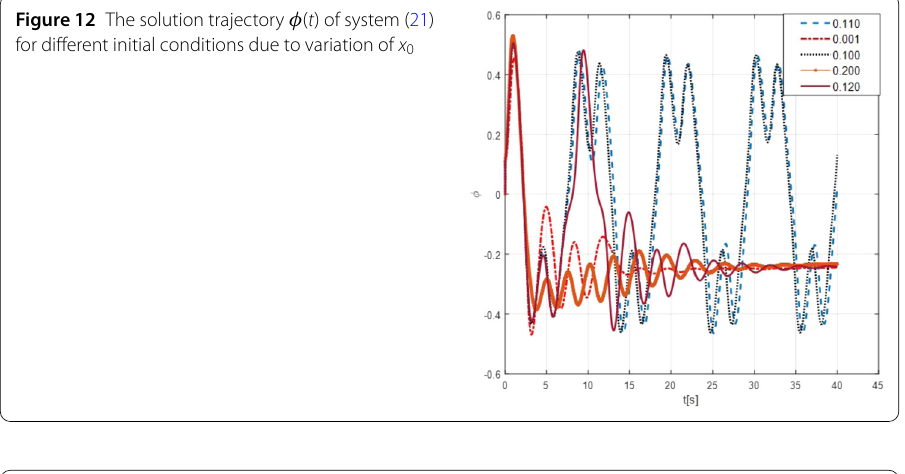
Figure 13 The solution trajectory φ ( t ) of system (21) for different initial conditions due to variation of y